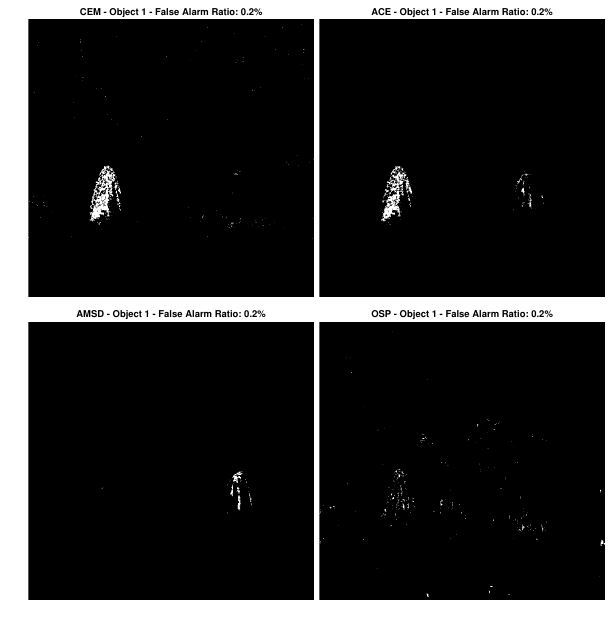
Figure 11. Object 1 target detection.